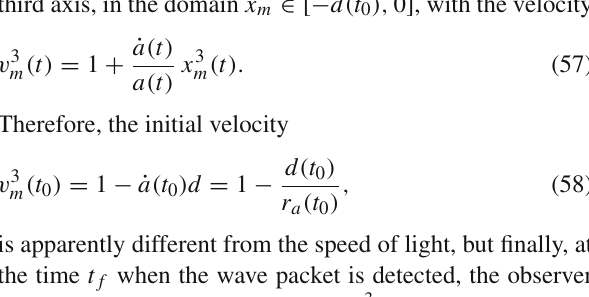
It remains to evaluate the space dispersion of the wave packet, δ x ( t ) , defined as the width of the function I ( t , X ) at a given time. This depends on the width δ X of the function (cid:21)( X ) + (cid:21)( − X ) , which is a constant quantity depending on the profile of this function. Then, according to Eq. (44), we deduce that the physical dispersion, δ x ( t ) = δ Xa ( t ) , evolves from δ x ( t 0 ) = δ Xa ( t 0 ) up to δ x ( t f ) = δ Xa ( t f )